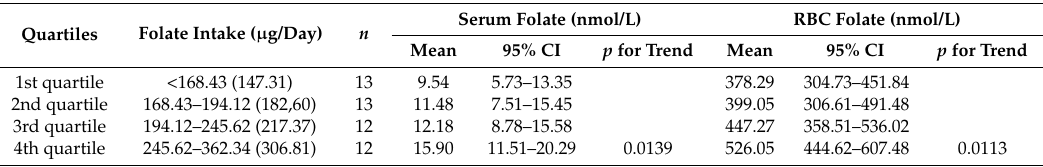
Table 4. Estimated serum and RBC folate concentrations by quartile of intake assessed by F-FFQ among Serbian women of reproductive age.